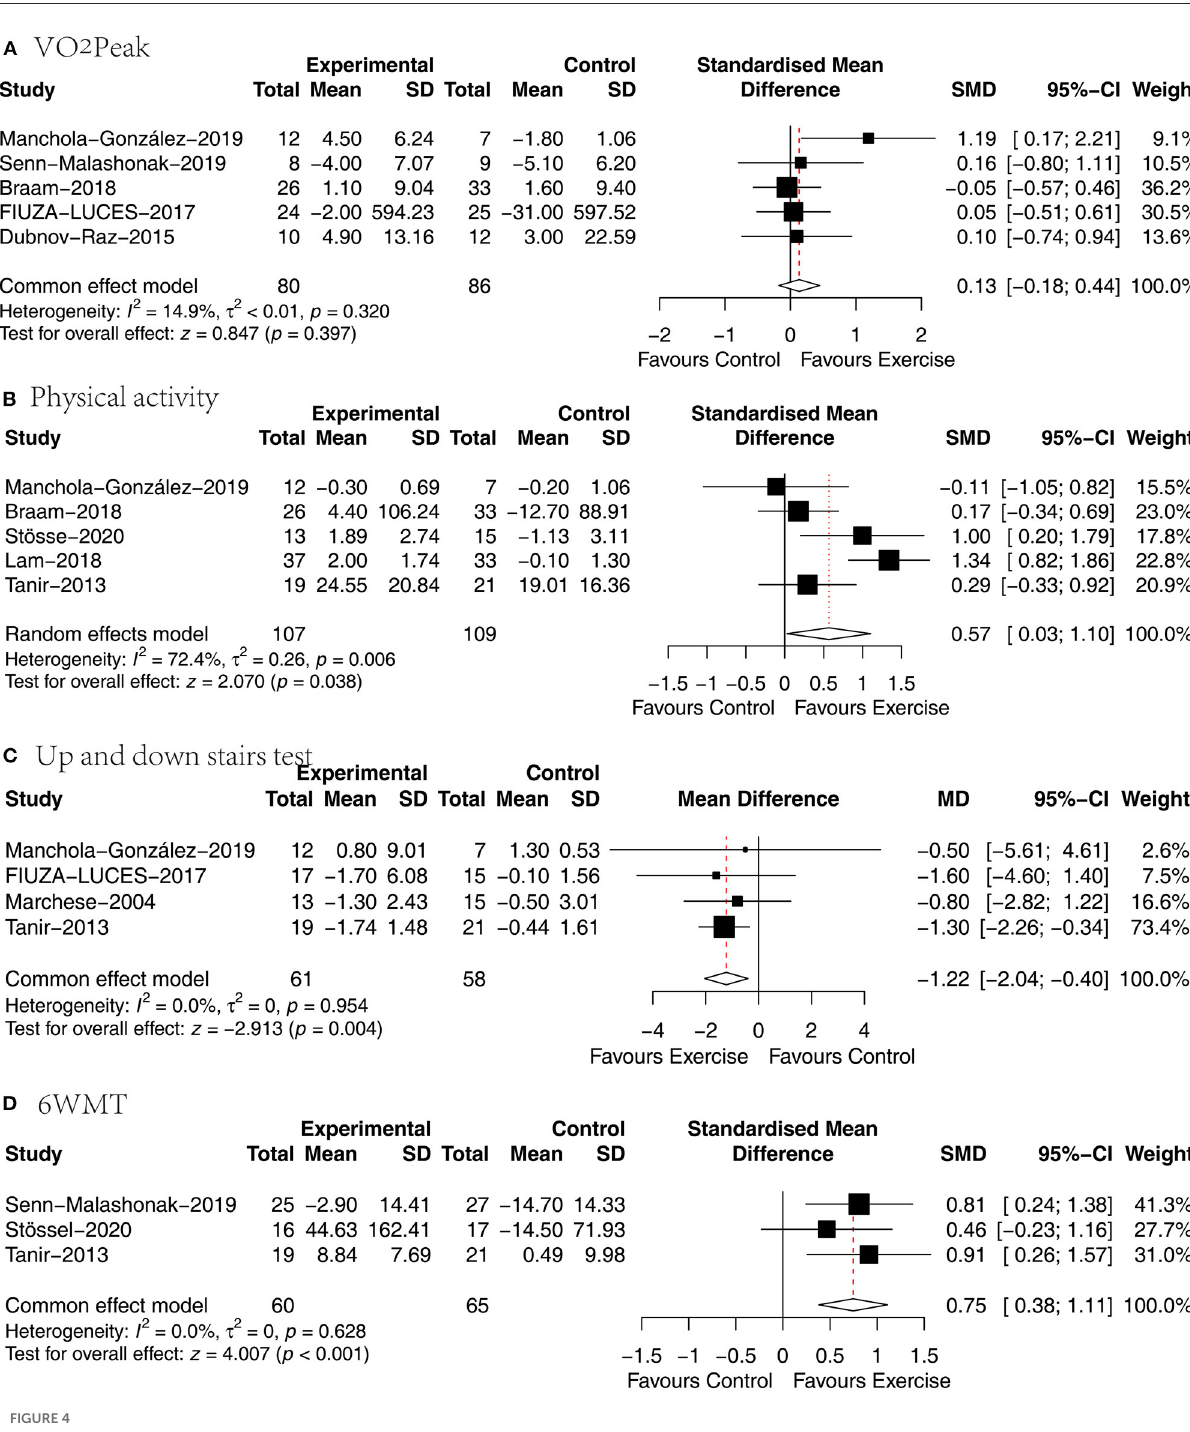
Depression Two papers (27, 34) analyzed the effect of concurrent training on the degree of depression in children with malignancy, and the SMD was chosen for pooling effect sizes because of the different depression measurement tools. There was a